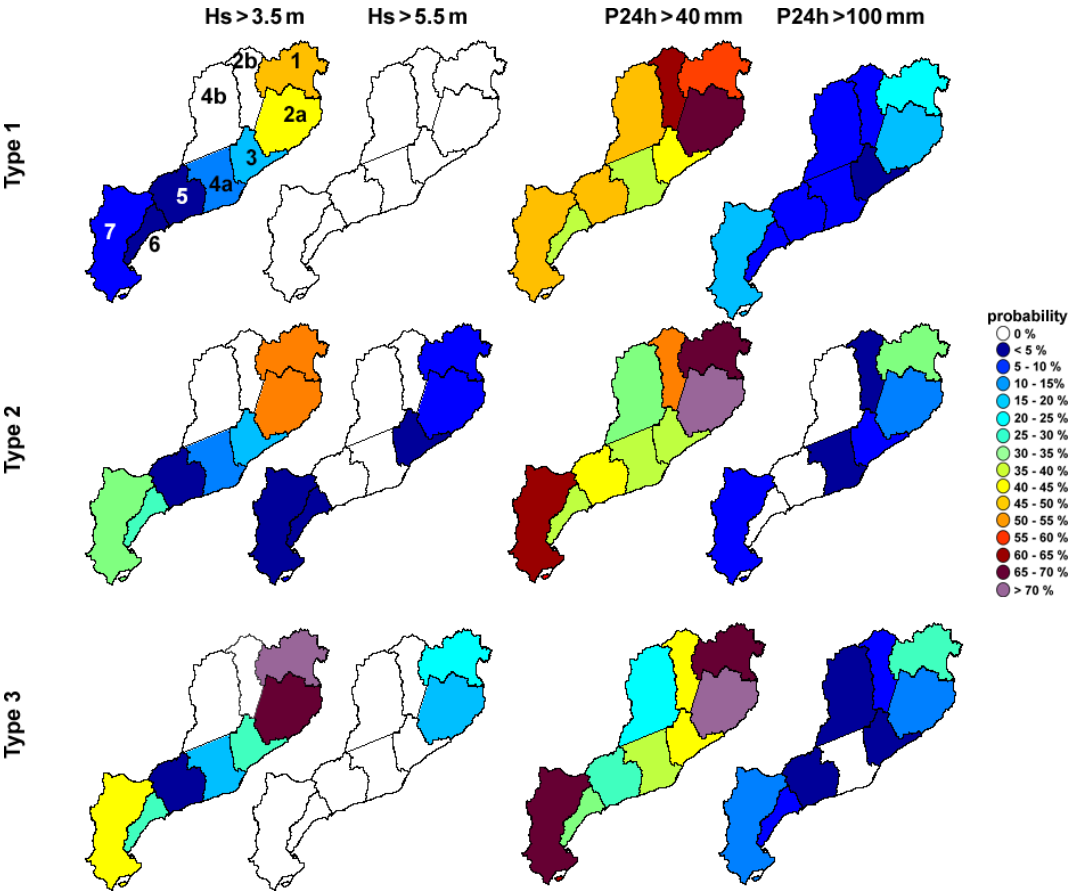
Figure 10. Spatial distribution of the probability of exceedance for different thresholds of H s (3.5 and 5.5m) and P24h (40 and 100mm) conditioned to each synoptic type. Area numbers are specified on the top left map.